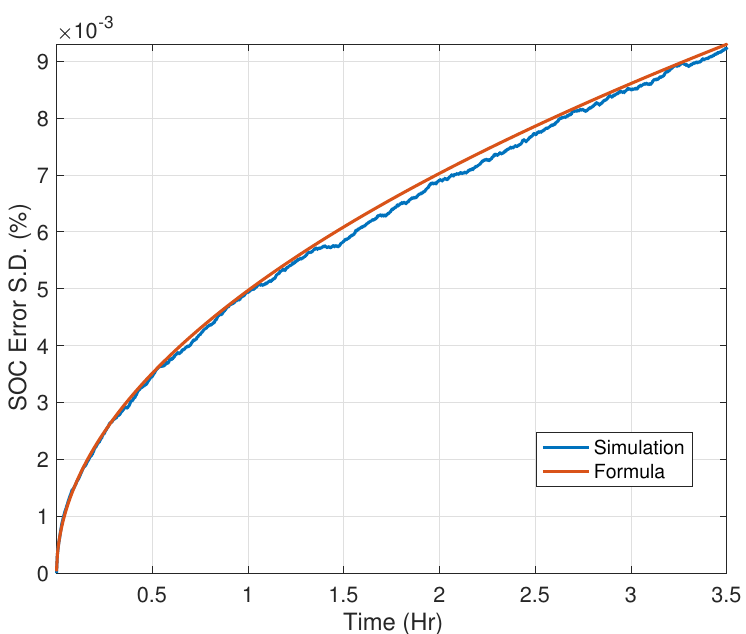
Figure 6. Standard deviation of the SOC error due to measurement error in current. Simulated value is plotted in comparison with the theoretical value derived in (29) shown against time that corresponds to n